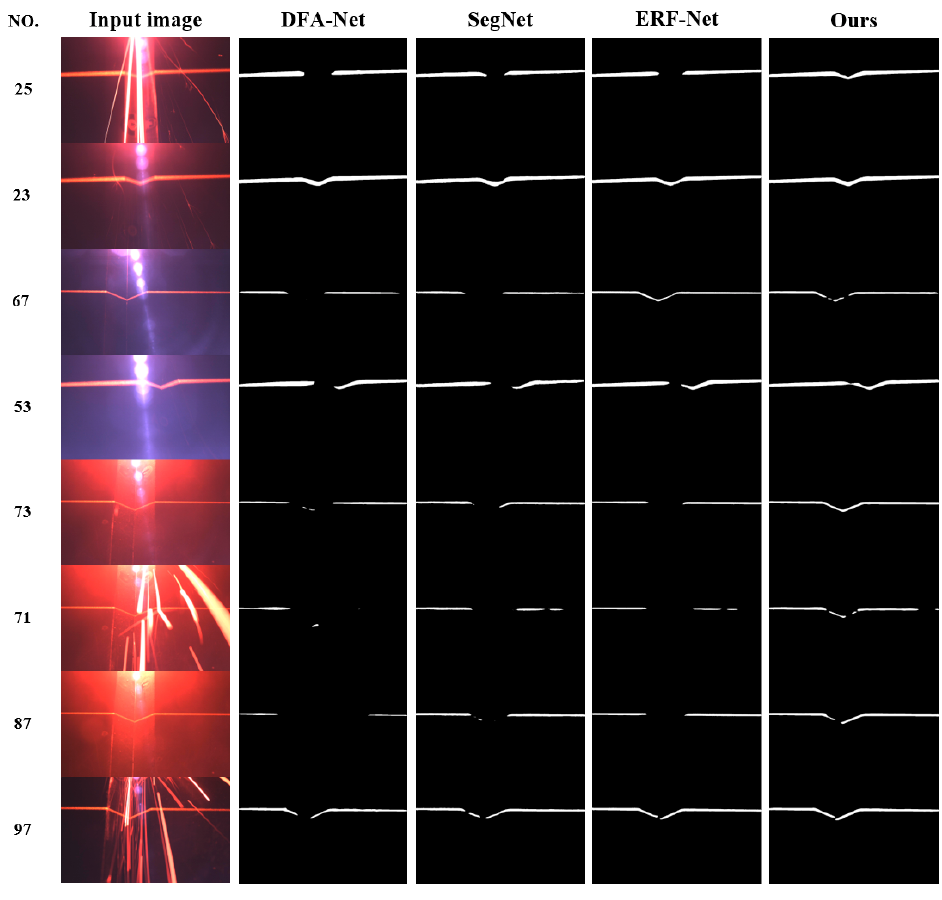
Figure 12. Extracted fringe centers and fitted straight lines: ( a , b ) segmentation succeeded and ( c , d ) segmentation failed. Table 9. Network segmentation success rate.